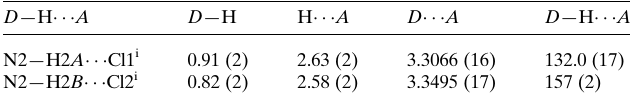
Table 2 Experimental details.